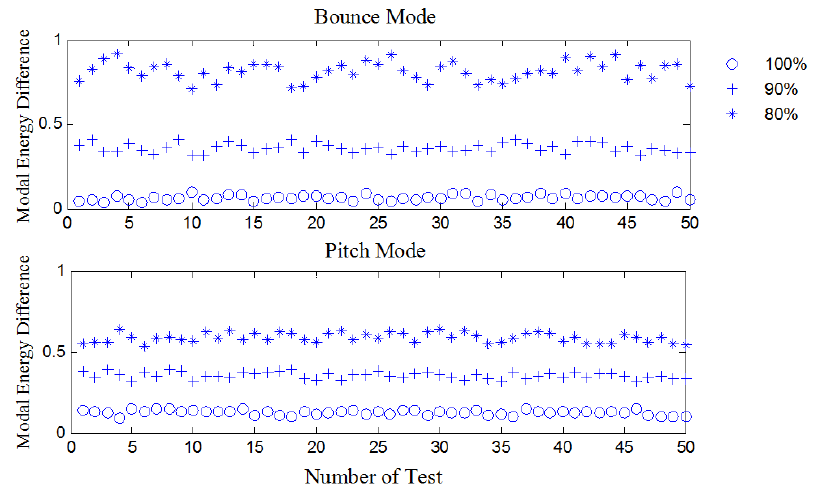
Figure 11. Identification of rear modal energy difference.